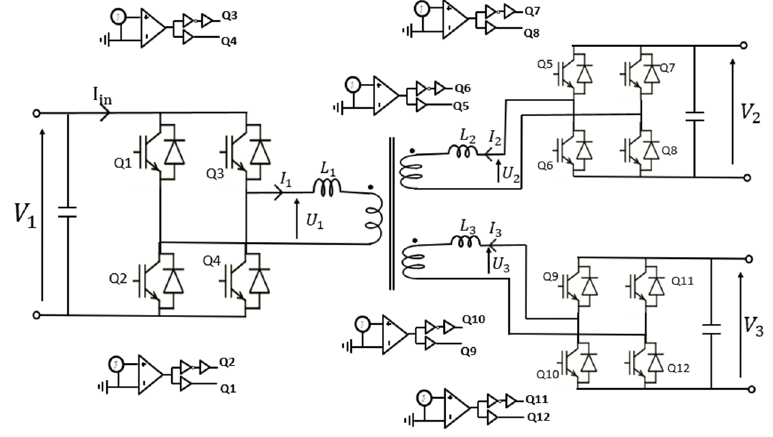
Figure 3. Schematic for the simulated TAB converter under the DPS control scheme. Table 1. Specifications of the simulated TAB converter.